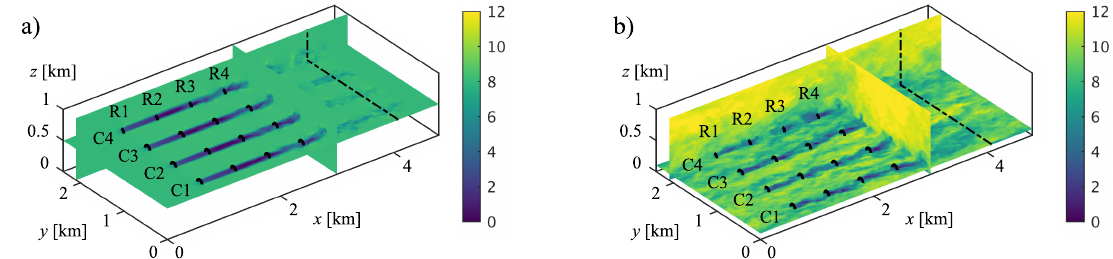
Figure 3. Snapshots of initial conditions for optimal control cases. ( a ) Uniform and constant inflow. ( b ) Turbulent inflow. Colors represent instantaneous streamwise velocity (cid:101) u x in m s − 1 . The black lines represent wind turbine locations. The black dashed line indicates the start of the fringe region. R1–R4 and C1–C4 indicate the numbering convention used for turbine rows and columns